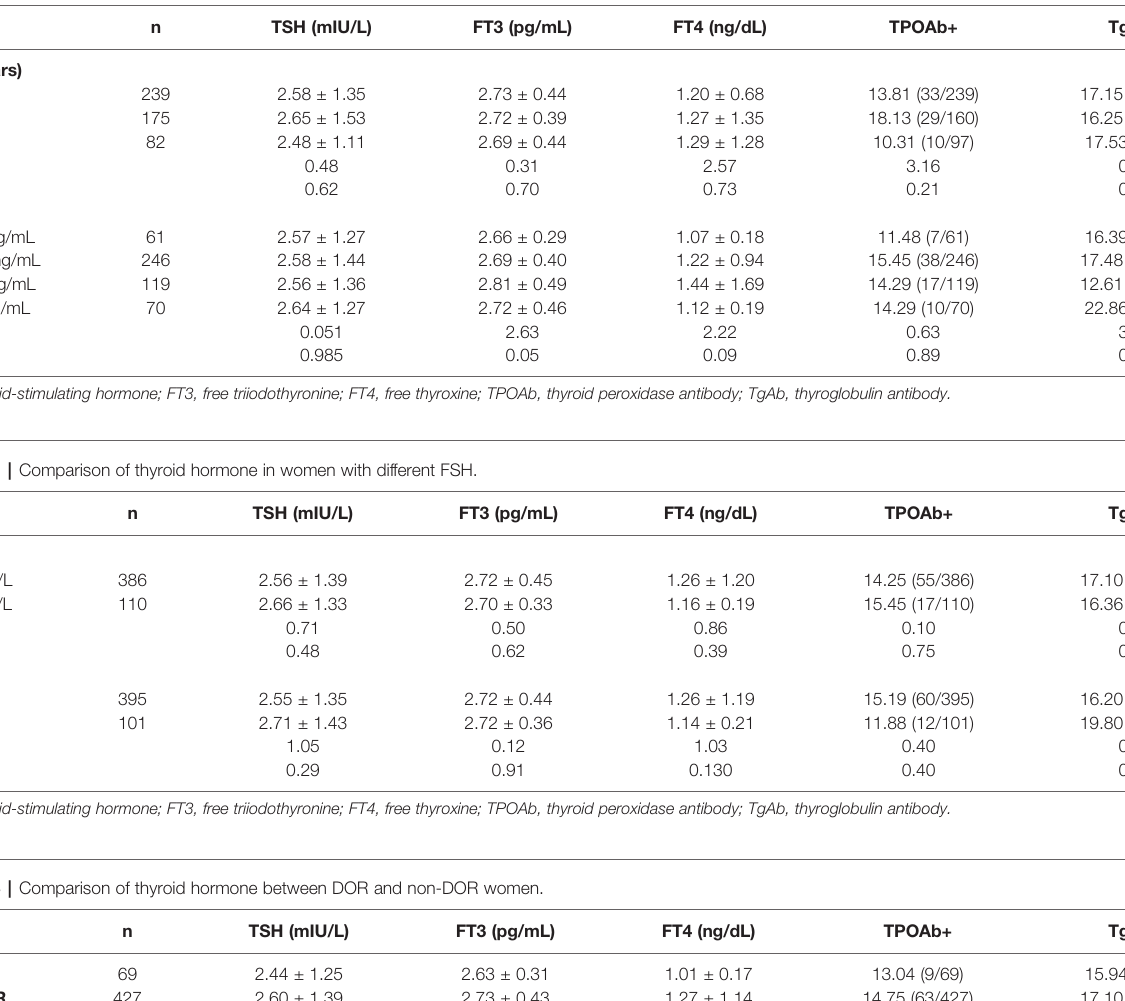
TABLE 6 | Comparison of thyroid hormone in women of different ages and AMH.